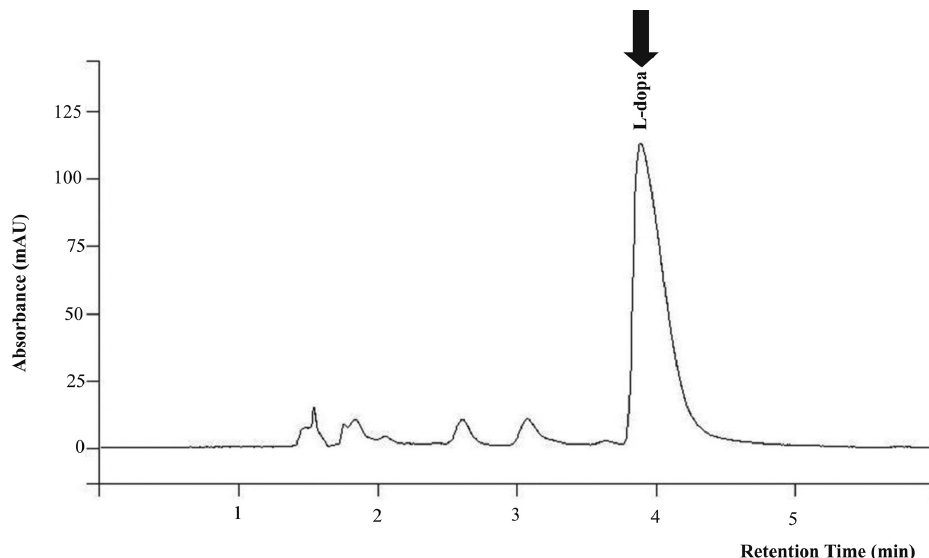
FIGURE 1 - Chromatogram of the acid extract of Mucuna pruriens seeds obtained by high-performance liquid chromatography. The highest peak indicates the presence of